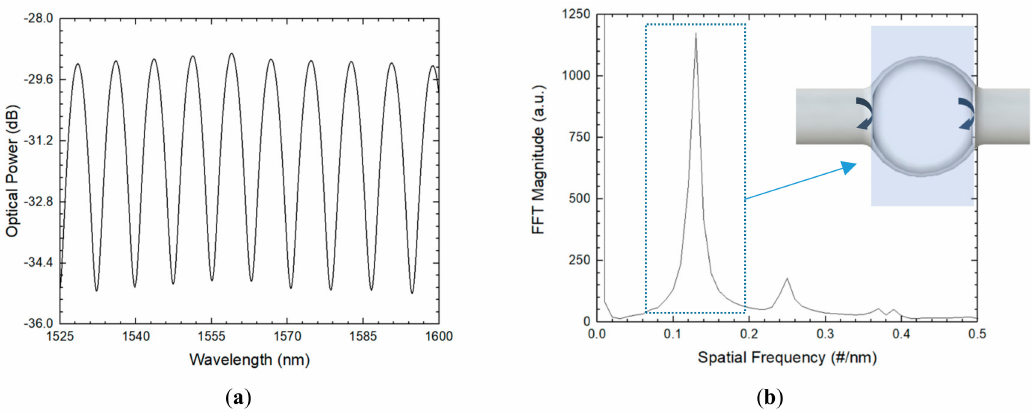
Figure 9. ( a ) Reflection spectrum of the inline hollow microsphere and ( b ) respective FFT with an inset representing the optical